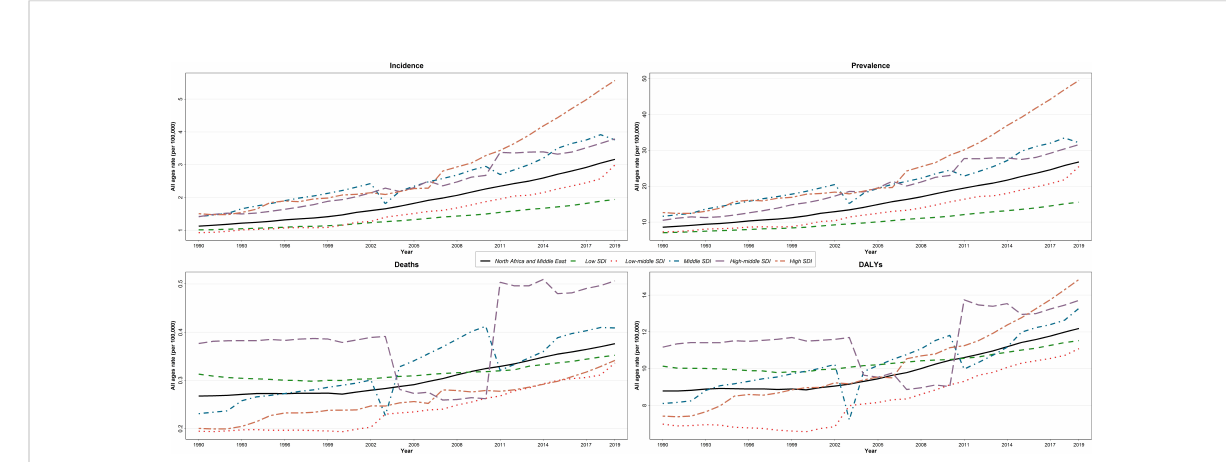
FIGURE 5 Trends of the rate of incidence, prevalence, deaths, and disability-adjusted life years (DALYs) of thyroid cancer in North Africa and Middle East regions among both sexes over 1990 – 2019, by sociodemographic index